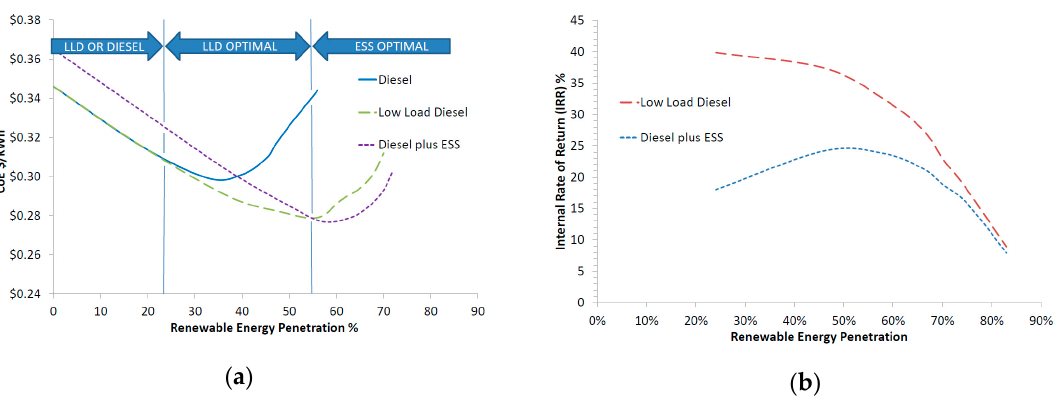
Figure 4. ( a ) CoE for a reduced RE resource, as a function of RE penetration for diesel, low load diesel and diesel plus energy storage architectures. Weaker RE resource is observed to reduce optimized RE penetrations across all cases; ( b ) IRR as a function of RE penetration for diesel and low load diesel.